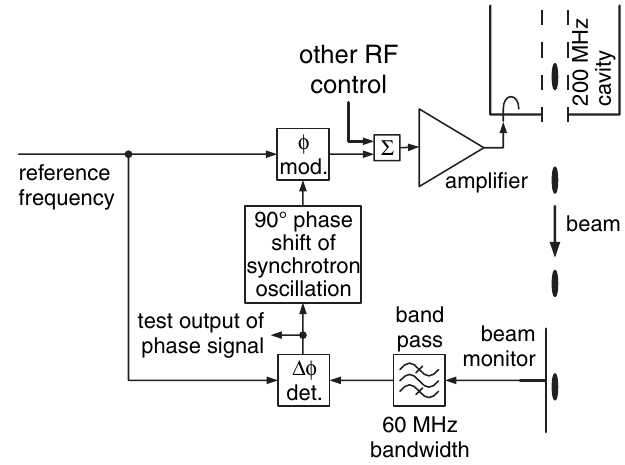
FIG. 5. (Color) rf voltage and energy during the SPS cycle (21.6 s). FIG. 6. Scheme of the longitudinal damper.